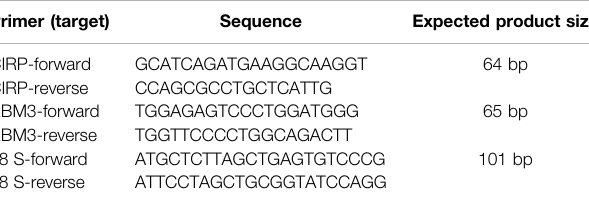
TABLE 2 | Primers used for